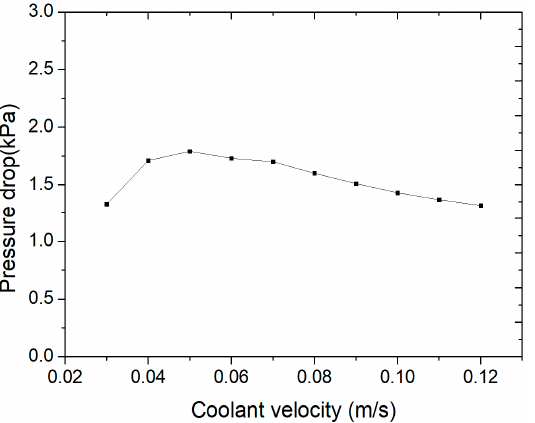
Figure 14. Variation of pressure drop versus different coolant inlet velocity.